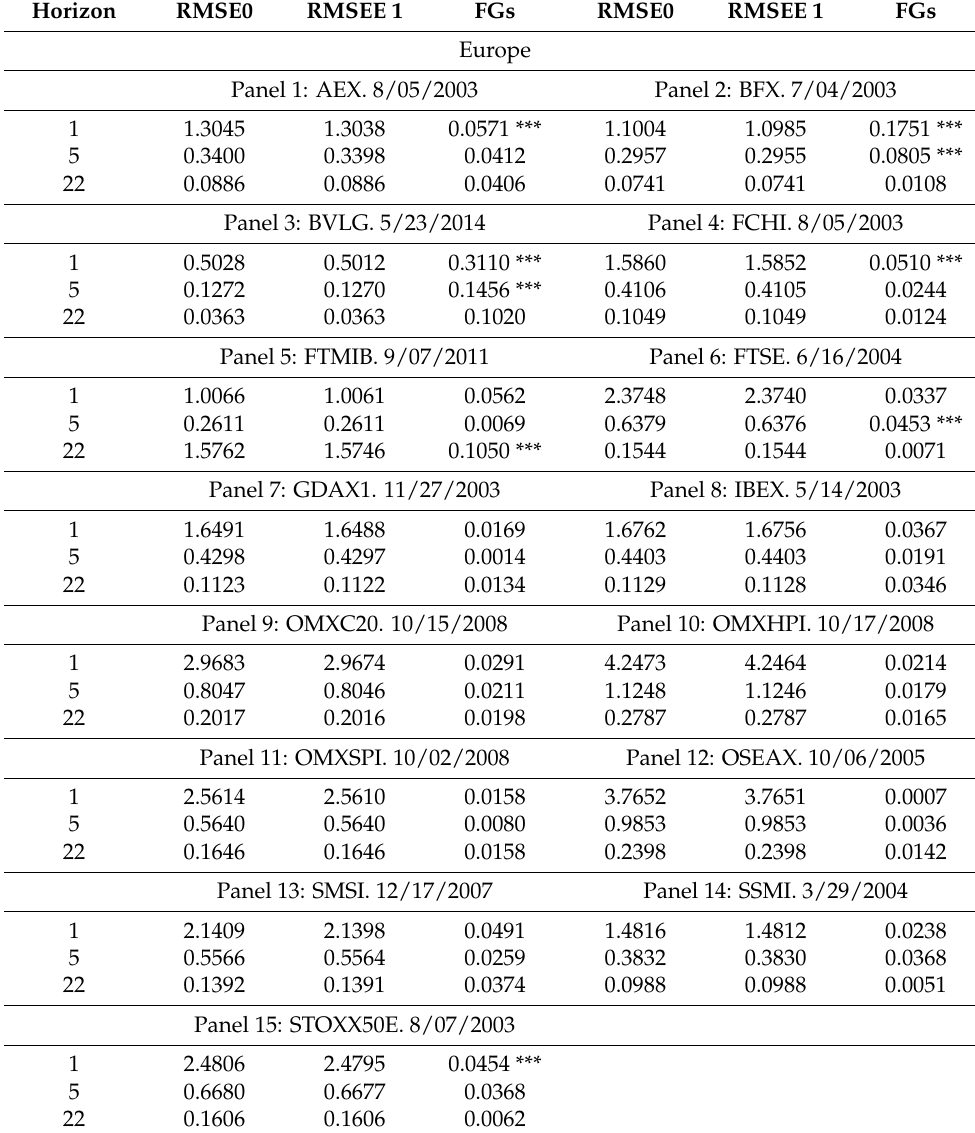
Table 2. Out-of-sample forecasting